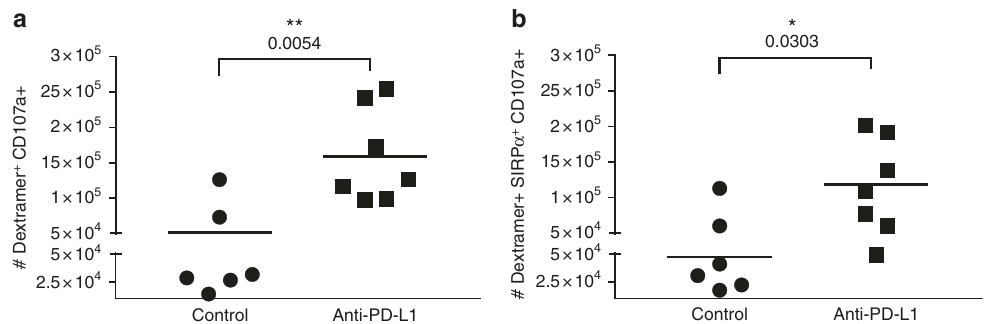
Fig. 9 Expansion of cytolytic Friend virus (FV)-speci fi c SIRP α + CD8 + T cells during programmed cell death ligand 1 (PD-L1) blockade. As described in Methods, mice chronically infected with FV were injected every other day with anti-PD-L1 blocking antibody and analyzed the second day following the fi nal injection for the number of dextramer + CD107a + ( a ) and dextramer + SIRP α + CD107a + ( b ) T cells in the spleen. Bars represent the mean and symbols represents individual mice ( n = 6 – 7) pooled from 2 independent experiments, with statistical differences analyzed by two-way unpaired